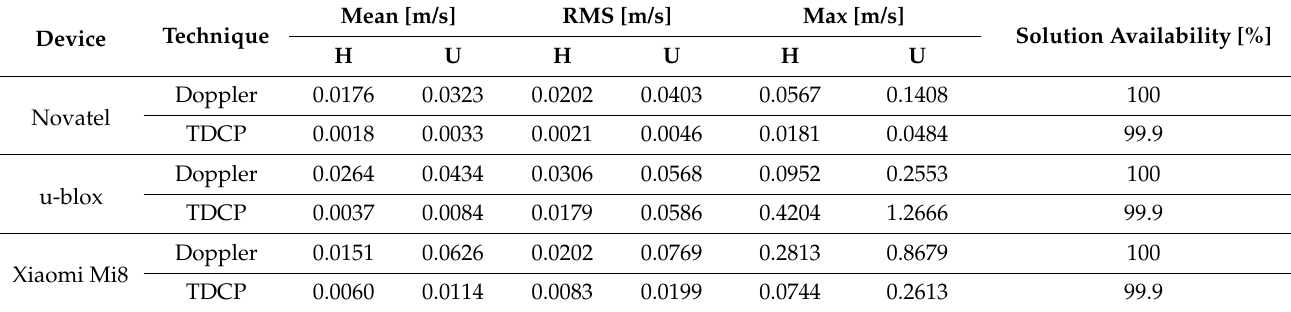
Table 1. Error analysis considering TDCP and Doppler techniques for Novatel Geodetic Receiver,